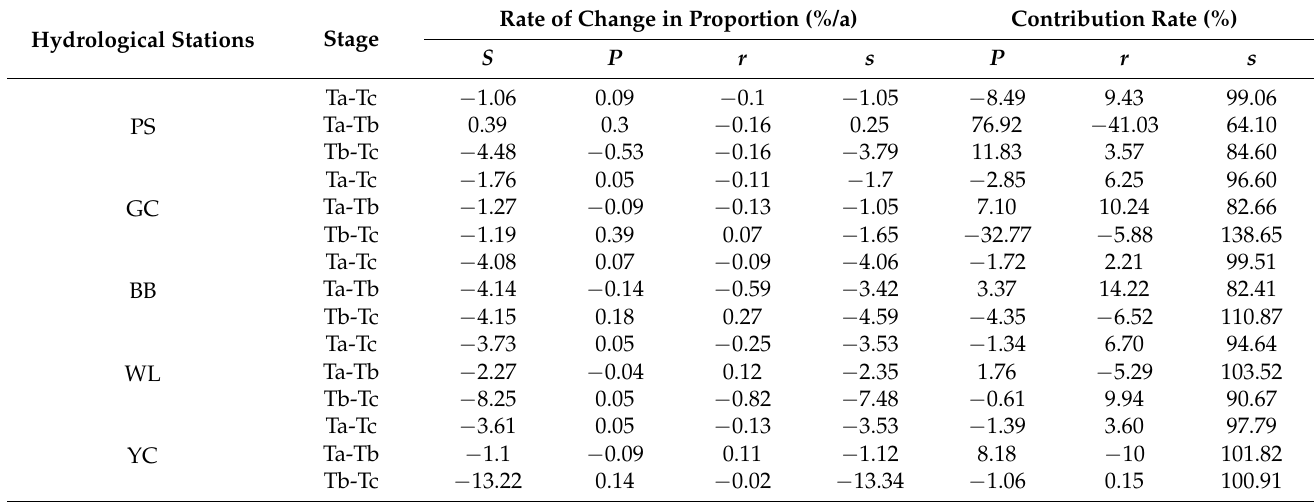
Table 6. Contribution of sediment characteristic factors to changes in sediment